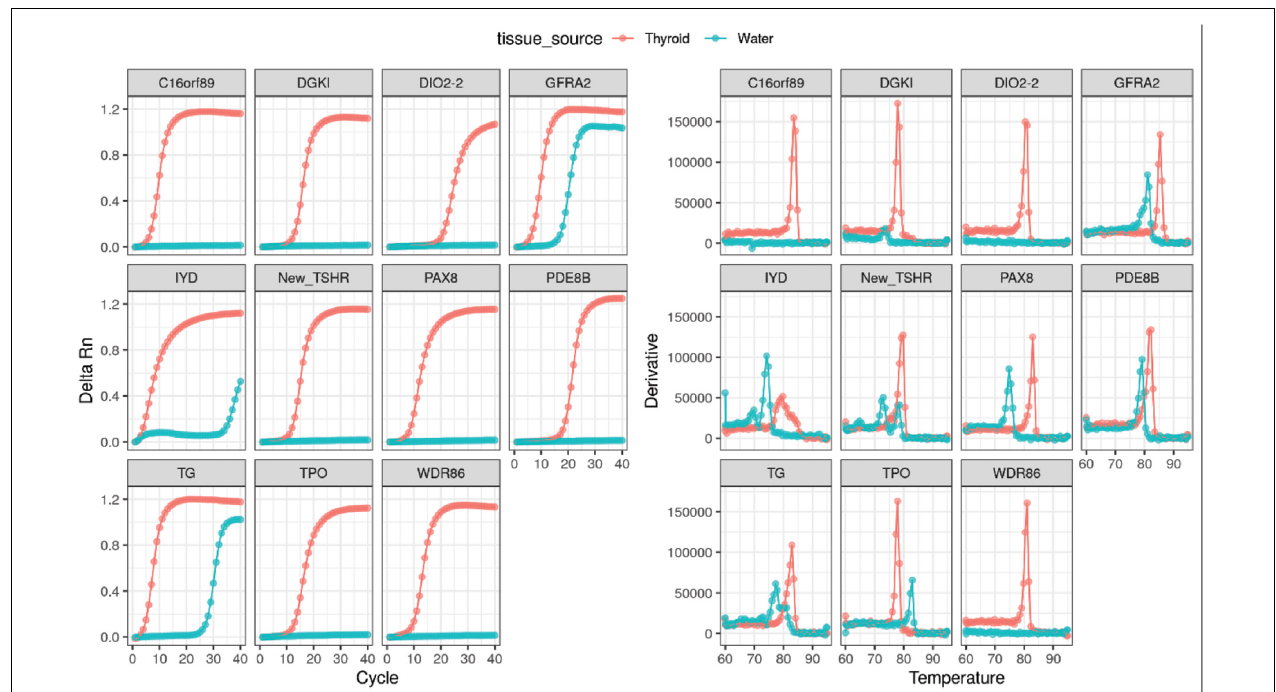
FIGURE 2 | Positive amplification curves and melt curves of all thyroid-specific RNA transcripts using directly extracted thyroid